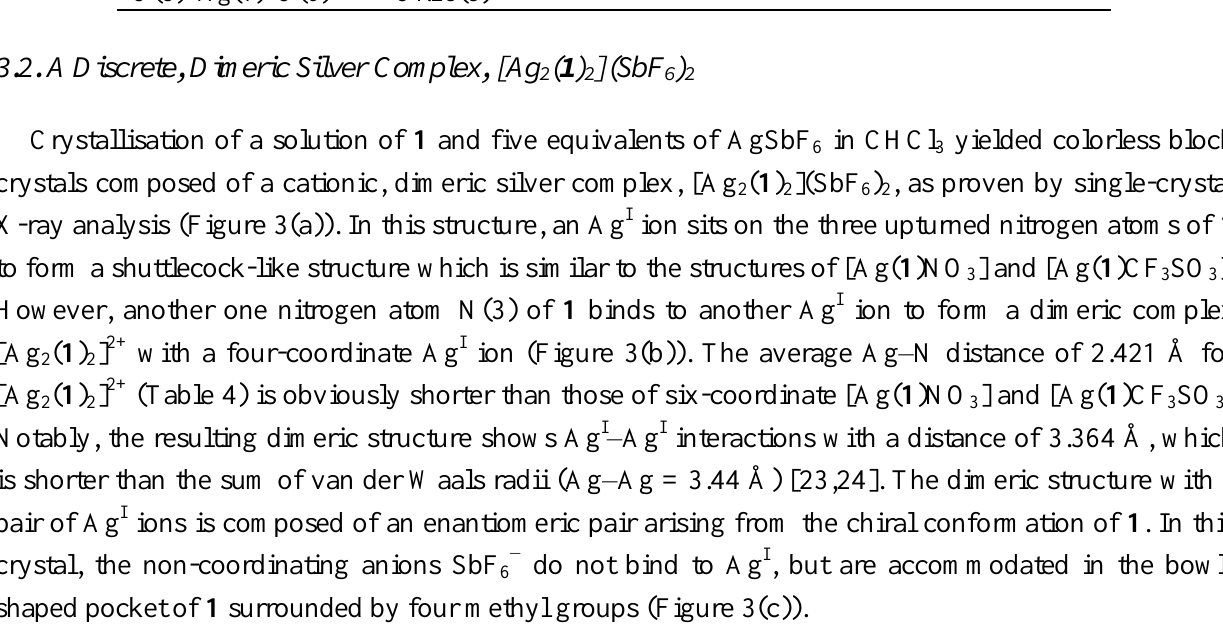
Table 3. Selected bond lengths (Å) and angles (deg) for [Ag( 1 )CF